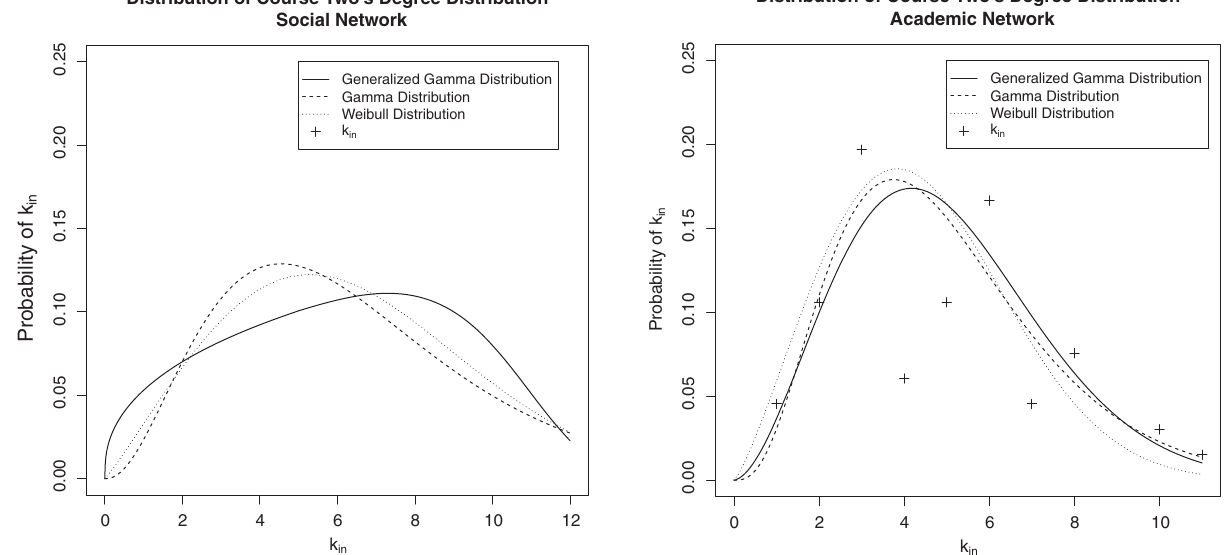
FIG. 3. Degree distribution for Course Two for the social (left) and the academic (right) network, and the estimations for the generalized Gamma, Gamma, and Weibull distributions.